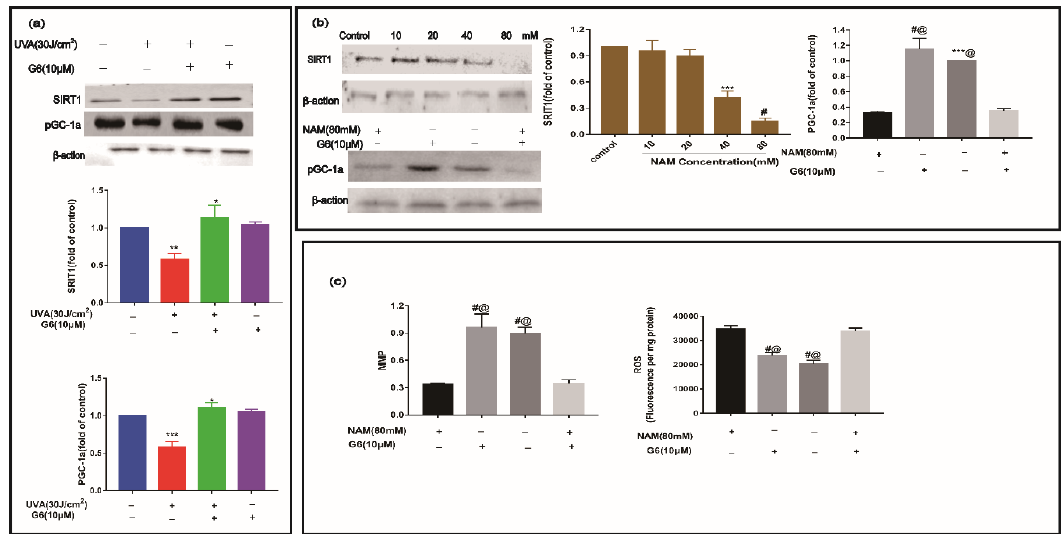
Figure 8. E ff ect of G6 on SIRT1 and pGC1a protein expression in HaCaT cells. ( a ) HaCaT cells were treated with or without G6 for 48 h, and were then incubated in the presence or absence of UVA. ( b ) Furthermore, HaCaT cells were incubated in the presence or absence of 80 mM NAM, and treated with or without G6 for 48 h. ( c ) The levels of MMP and ROS. Values are the mean ± S.E.M of results from at least three independent experiments, significant di ff erence compared to the control group, *** p < 0.001 and # p < 0.0001; ***,@ p < 0.001 and #,@ p < 0.0001, compared with the NAM-treated group, * p < 0.05, ** p <